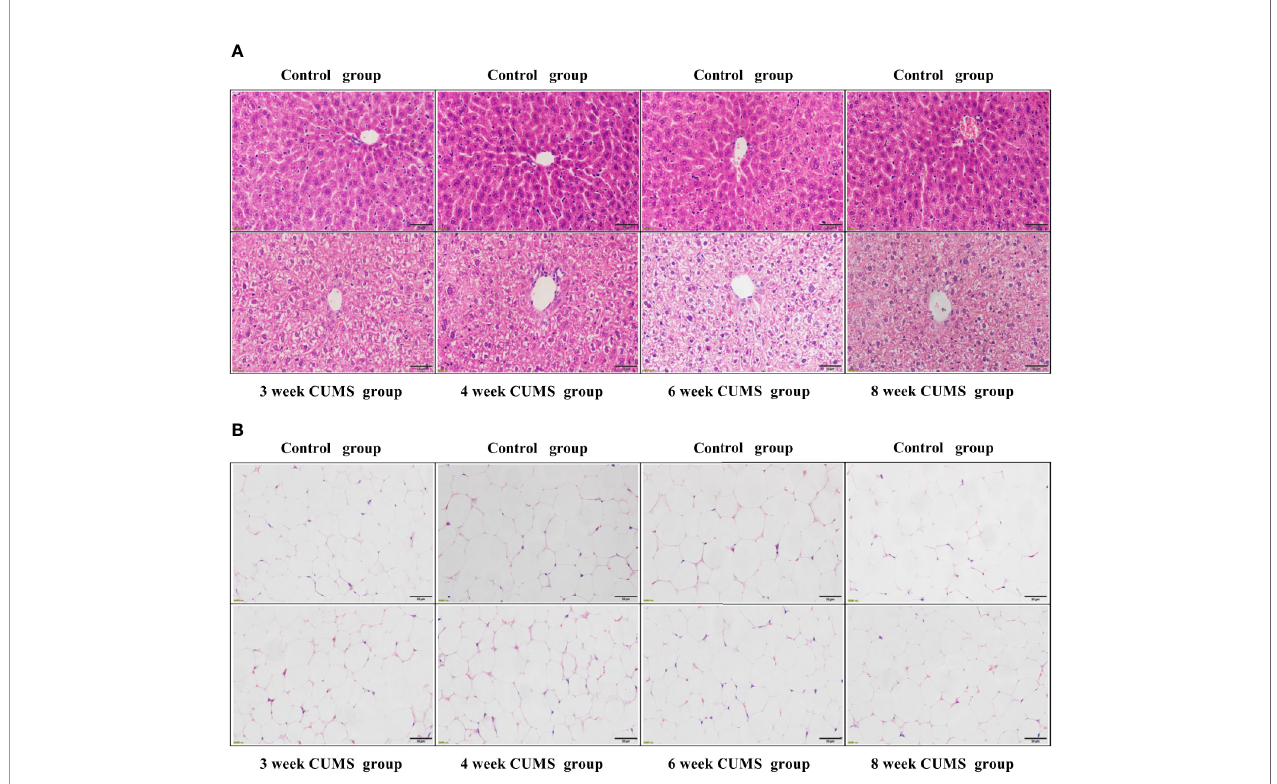
FIGURE 4 | The in fl uence of CUMS on hepatocytes and adipocytes using H&E staining. (A) Representative micrographs of rat liver tissues under a light microscope (scale bar = 50 m m, 400× magni fi cation). (B) Representative micrographs of abdominal adipose tissues under a light microscope (scale bar = 50 m m, 400× magni fi